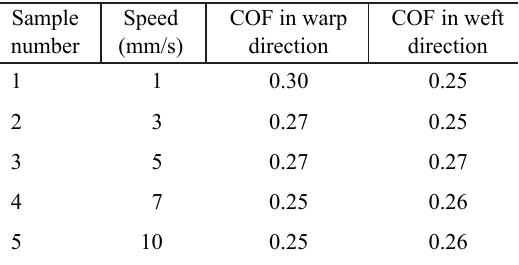
Table 4. COF results of TiAlN coated steel balls for